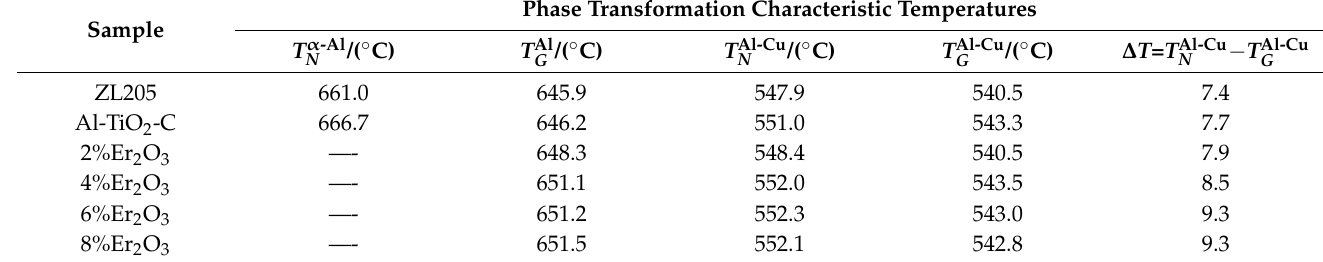
Table 3. Solidification characteristic parameters of the